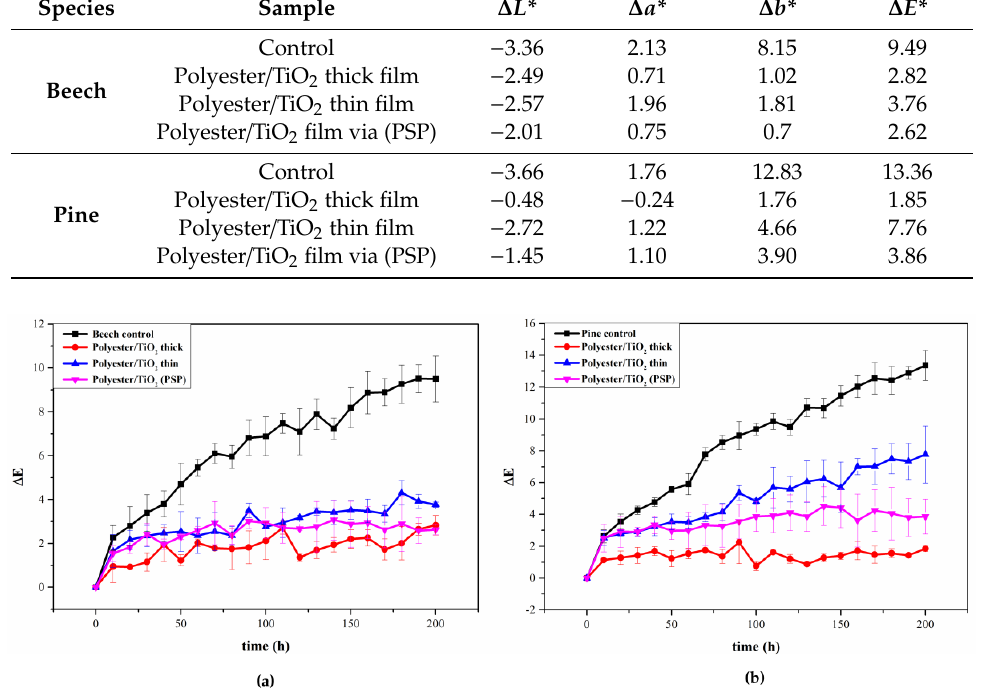
Figure 6. Change of total colour ∆ E* of coated and uncoated wood samples depending upon the time of irradiation of ( a ) beech and ( b ) pine.